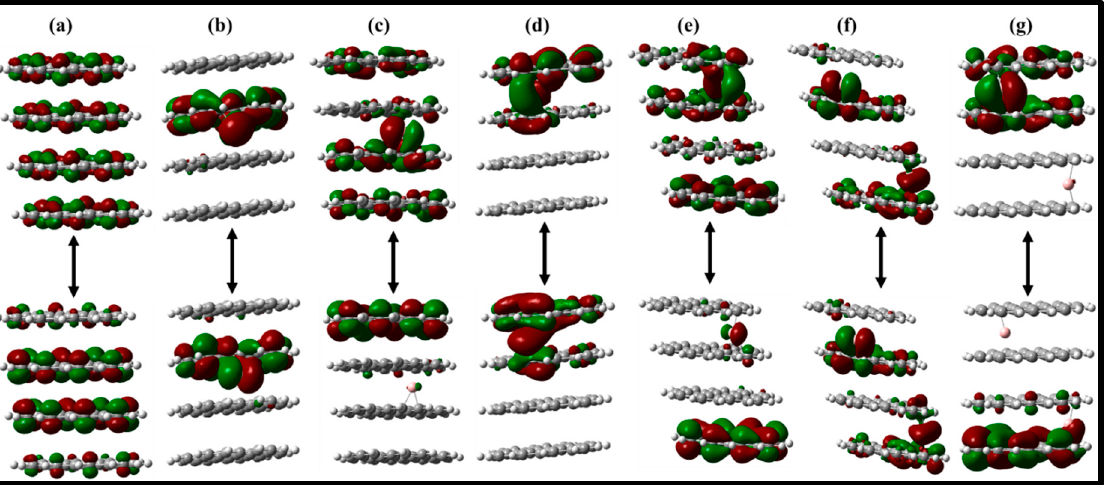
Figure 4. Molecular orbital HOMO (Lower) and LUMO (upper) of ( a ) tetralayer graphene sheet (TTG), ( b ) B@TTG-sym, ( c ) B 3+ @TTG-sym, ( d ) B@TTG-asym, ( e ) B 3+ @TTG-asym, ( f ) 2B@TG (side and top views), and ( g ) 2 B 3+ @TTG (side and top views).